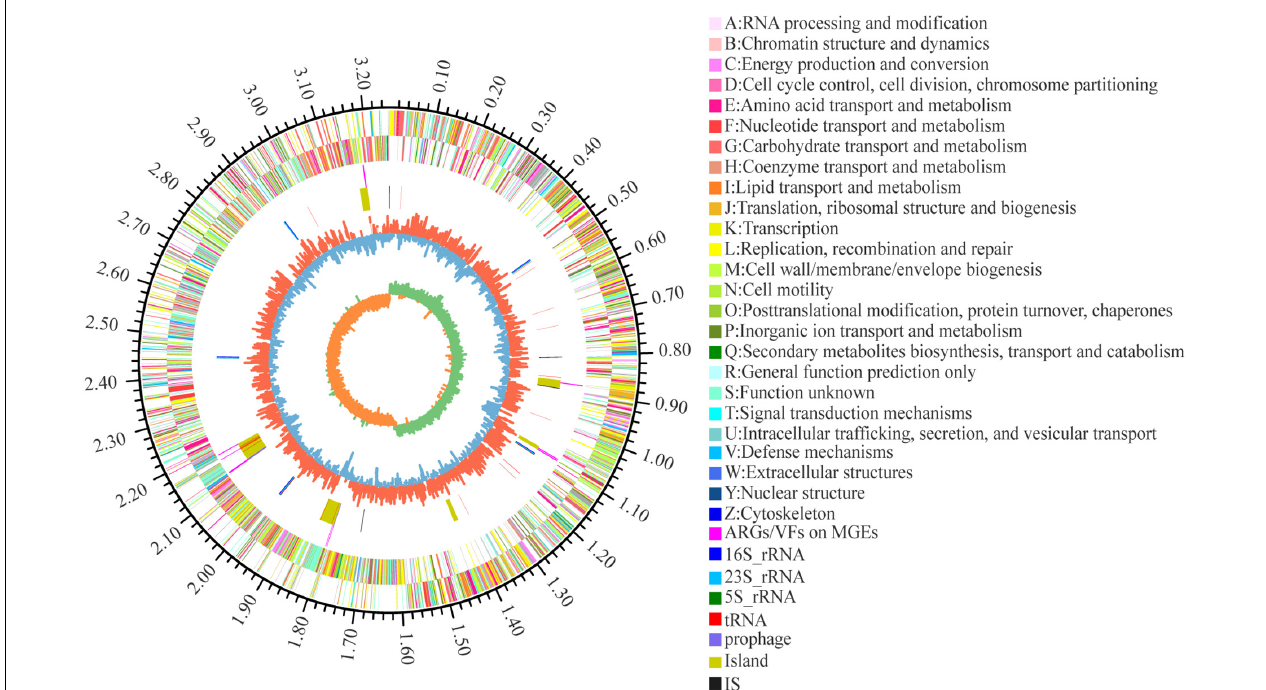
FIGURE 5 | Circular representation of L. plantarum W2 genome. The outer scale is in mega bases (Mb). Circle 1 (from outside to inside), the marker of genome size. Cycles 2 and 3, CDS with positive and negative chain, different colors represent different functional classifications; Circle 4, ARGs and VFs located on genomic islands and prephages; Circle 5, islands and prephages (yellow), insertion sequences (IS, black), rRNA (blue) and tRNA (red); Circle 6, GC content, the higher value makes redder, the lower makes bluer. Circle 7, GC-skew value, skew+ are expressed in green, skew- are expressed in orange.